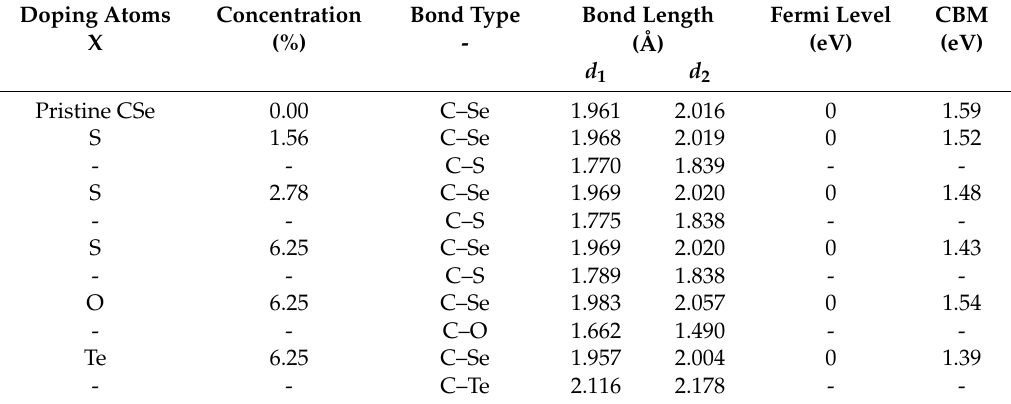
Table 1. Geometric parameters, Fermi level, and conduction band minimum (CBM) of monolayer CSe for X-doping (X = O, S and Te) with different